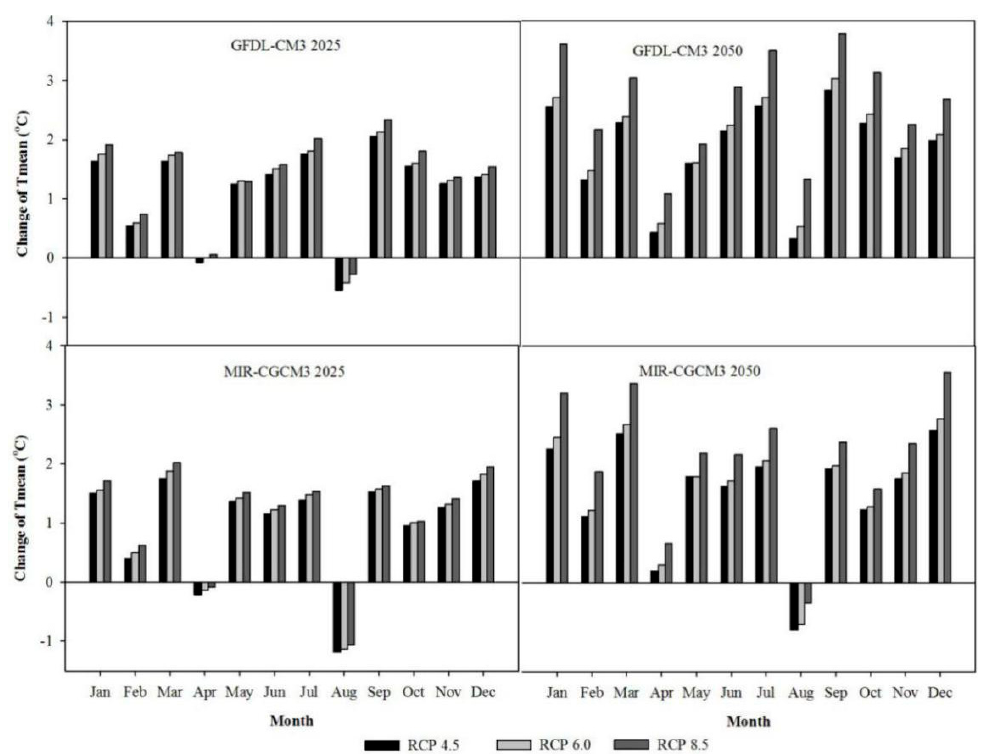
Figure 4. Changes in mean temperature (°C) projected for 2025 and 2050 based on three RCPs, and RCP 8.5 for two GCMs compared with 1961–1990 for Guanzhong Plain.